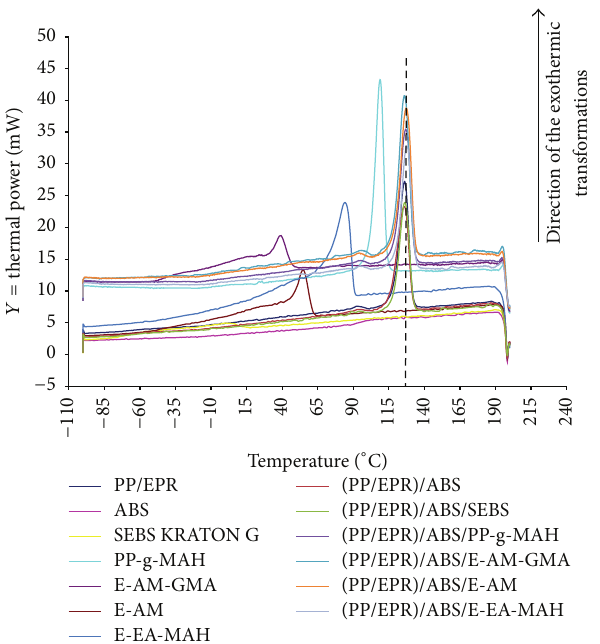
Figure7:DSCcurvesinthedirectionoftheexothermictransforma- tions of components and mixtures (PP/EPR)/ABS/compatibilizer (93.5)/5/1.5, for the first thermal cycle. For about 15mg of sample. 1 graduation 𝑌 = 5 mW.